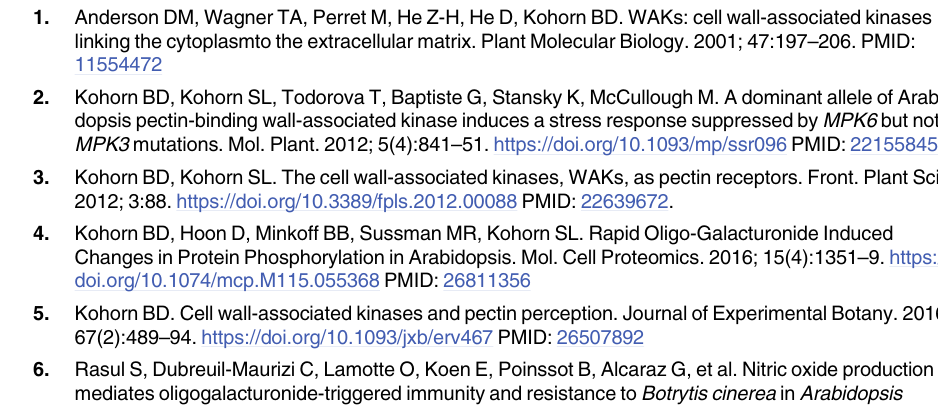
days post inoculation with single spore isolate of P . triticina . Genes Lr12 , Lr22 and Lr34 confer adult plant resistance (APR) of wheat against leaf rust. S7 Fig. Latent period of leaf rust. Latent period of leaf rust scored on flag leaves of susceptible cultivar Thatcher and isogenic lines Tc Lr12 , Tc Lr22 and Tc Lr34 inoculated with single spore isolate of Puccinia triticina . Genes Lr12 , Lr22 and Lr34 confer adult plant resistance (APR) of wheat against leaf rust. S8 Fig. Uredinia size. Uredinia size scored on flag leaves of susceptible cultivar Thatcher and spores isolate. Genes Lr12 , Lr22 and Lr34 confer adult plant resistance (APR) of wheat against leaf rust. S1 Table. Primers and reaction conditions for PCR. S2 Table. S2 List of TaWAK and TaWAK-like